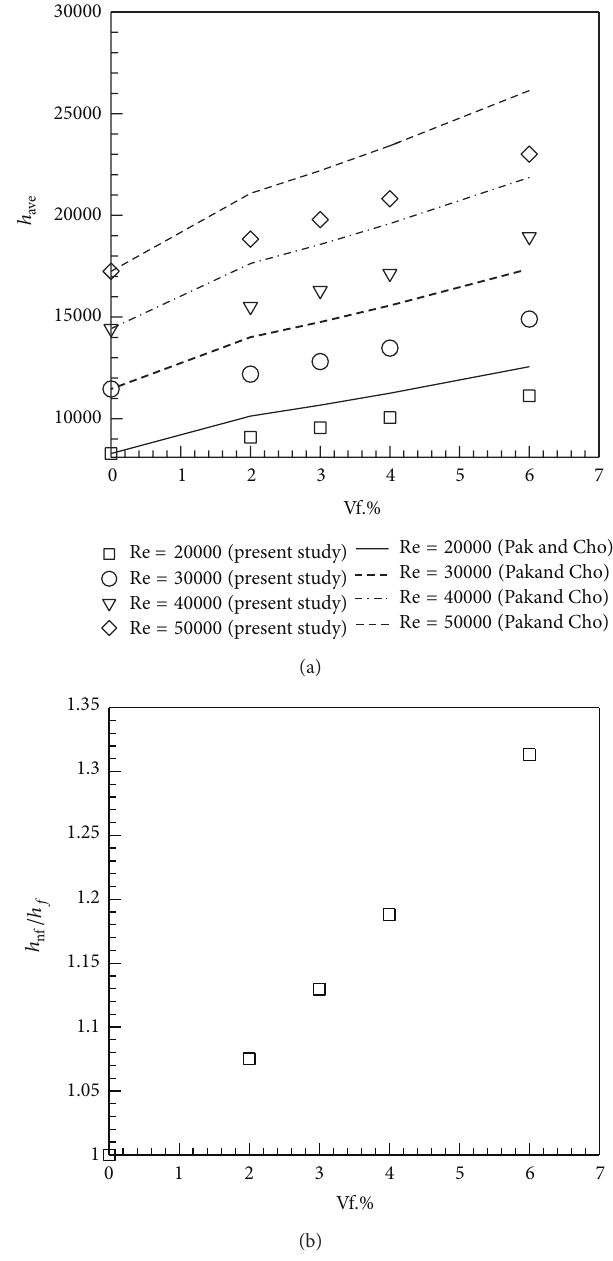
Figure 5: Effect of nanoparticle concentration on (a) average heat transfer coefficient and (b) heat transfer coefficient ratio.